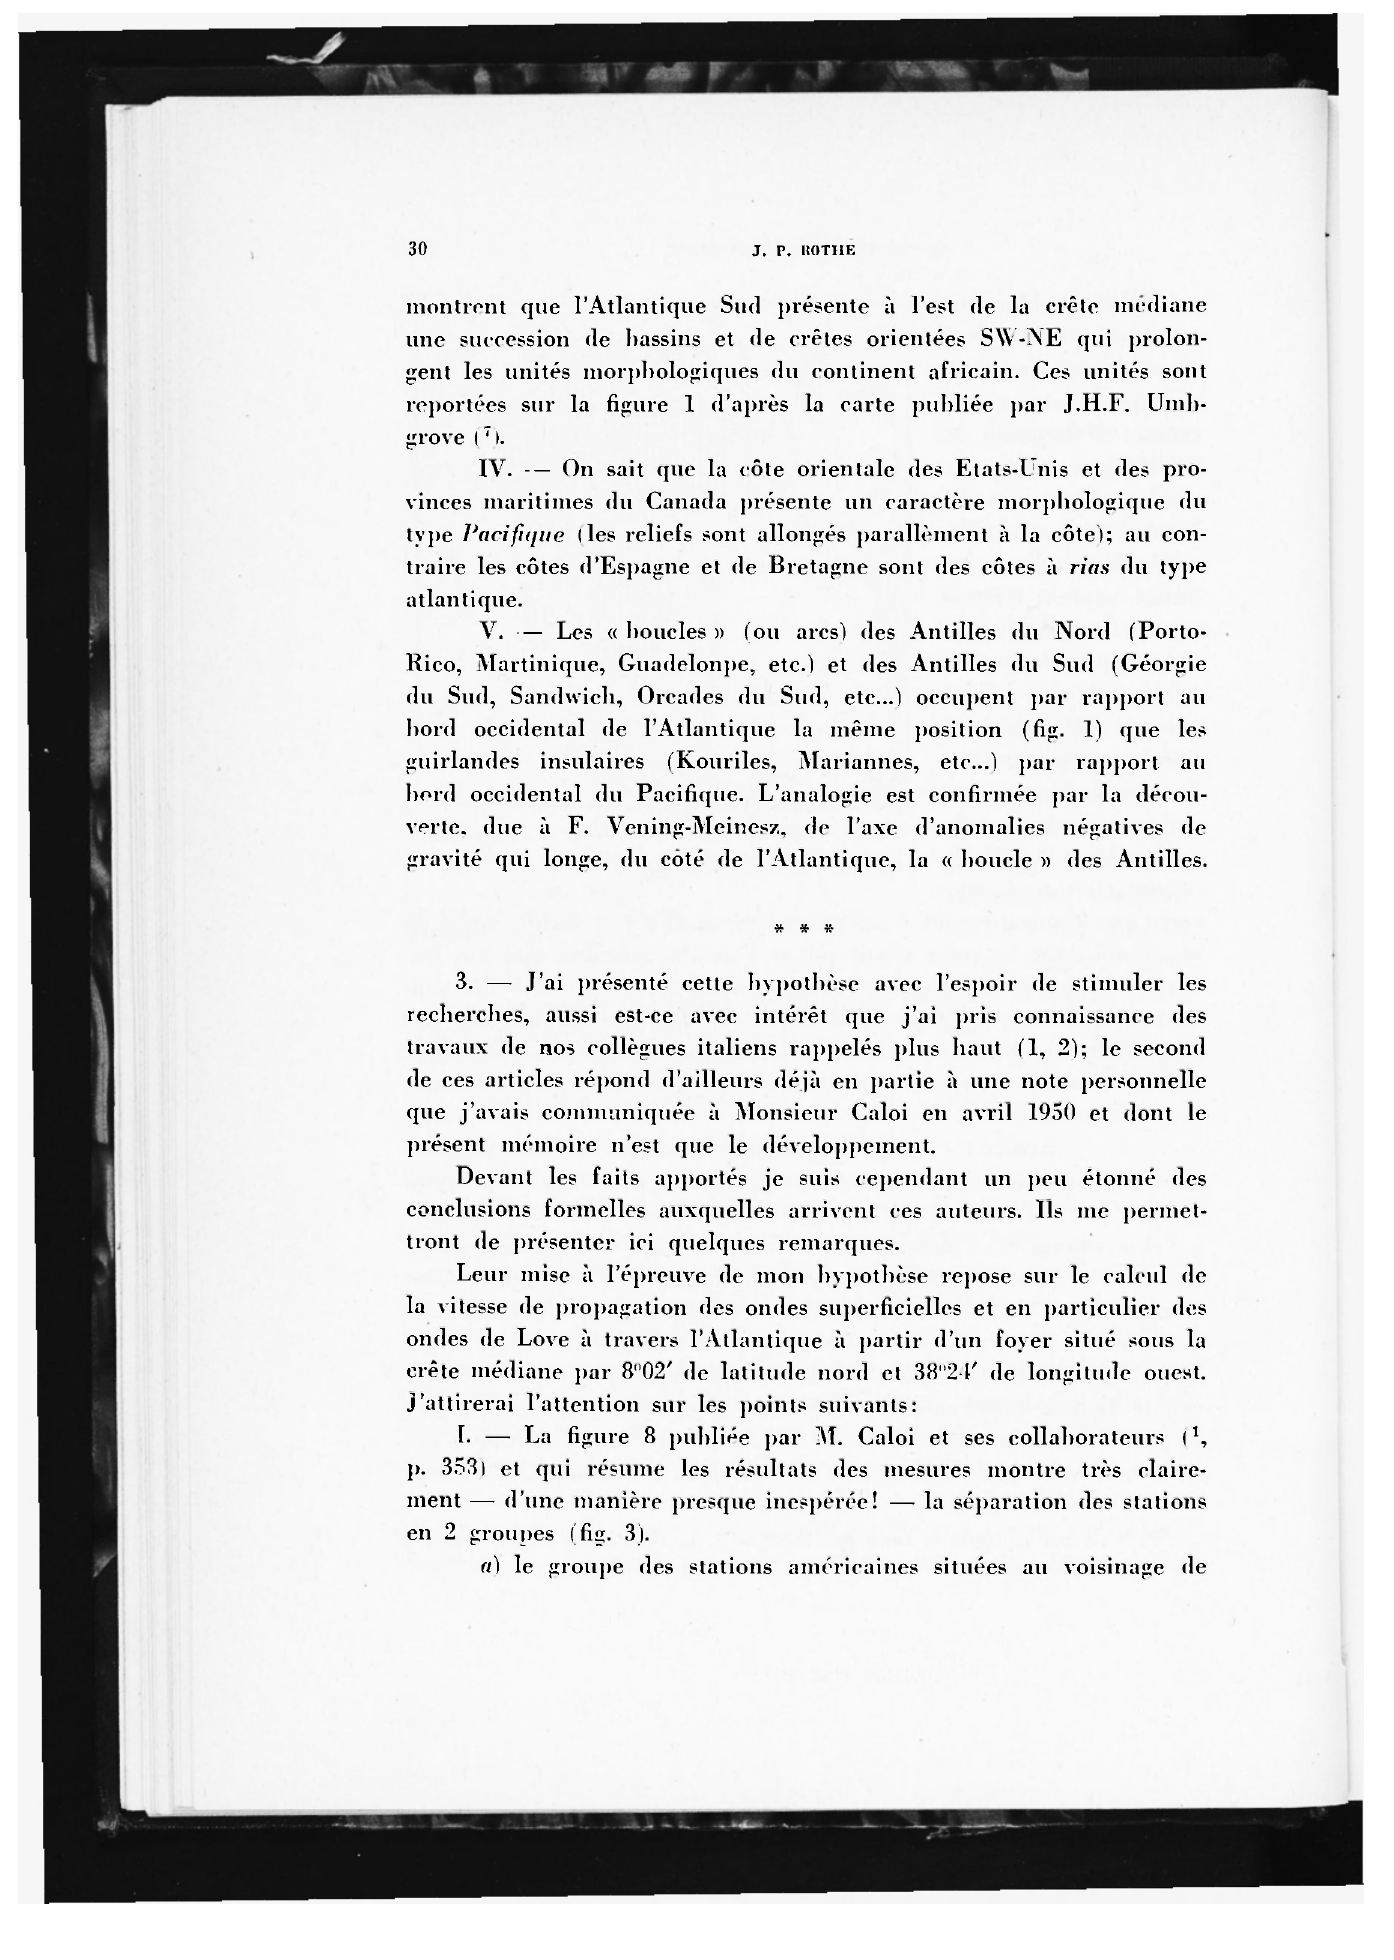
figure 1 d'après la carte publiée par J.H.F. Umb-